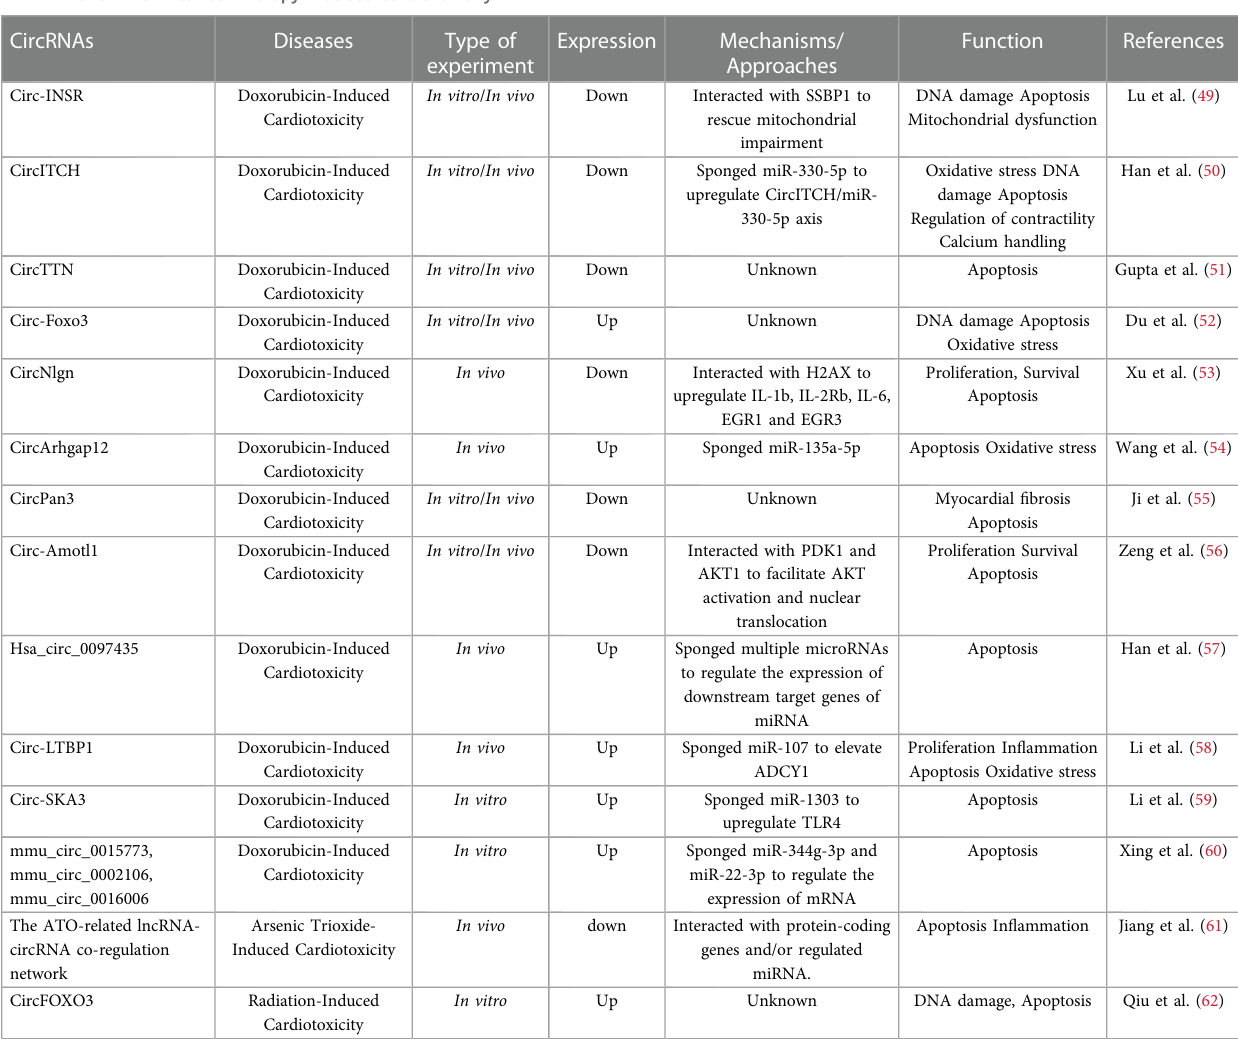
TABLE 1 circRNAs in cancer therapy-induced